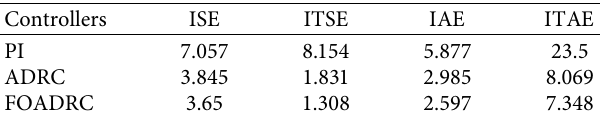
Table 4: Te error integral criteria of three controllers (double wind disturbance).